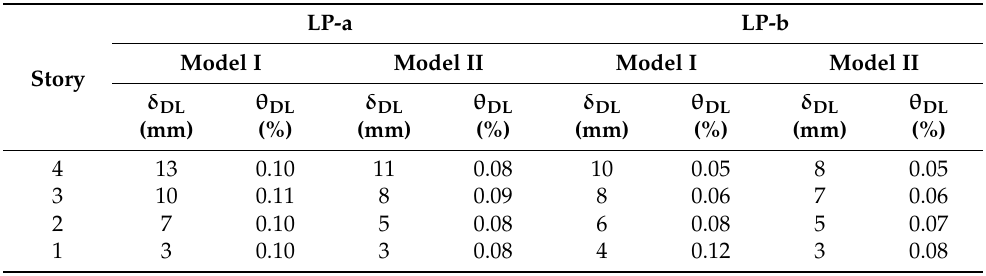
Table 5. Lateral maximum displacement and inter-story drift at each story of the